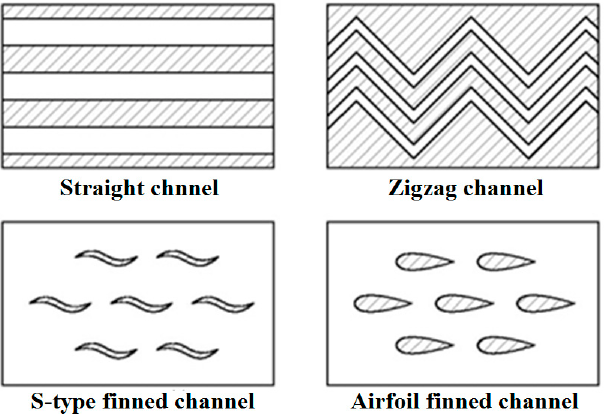
Figure 1. Four typical types of continuous and discontinuous fin PCHE channels.